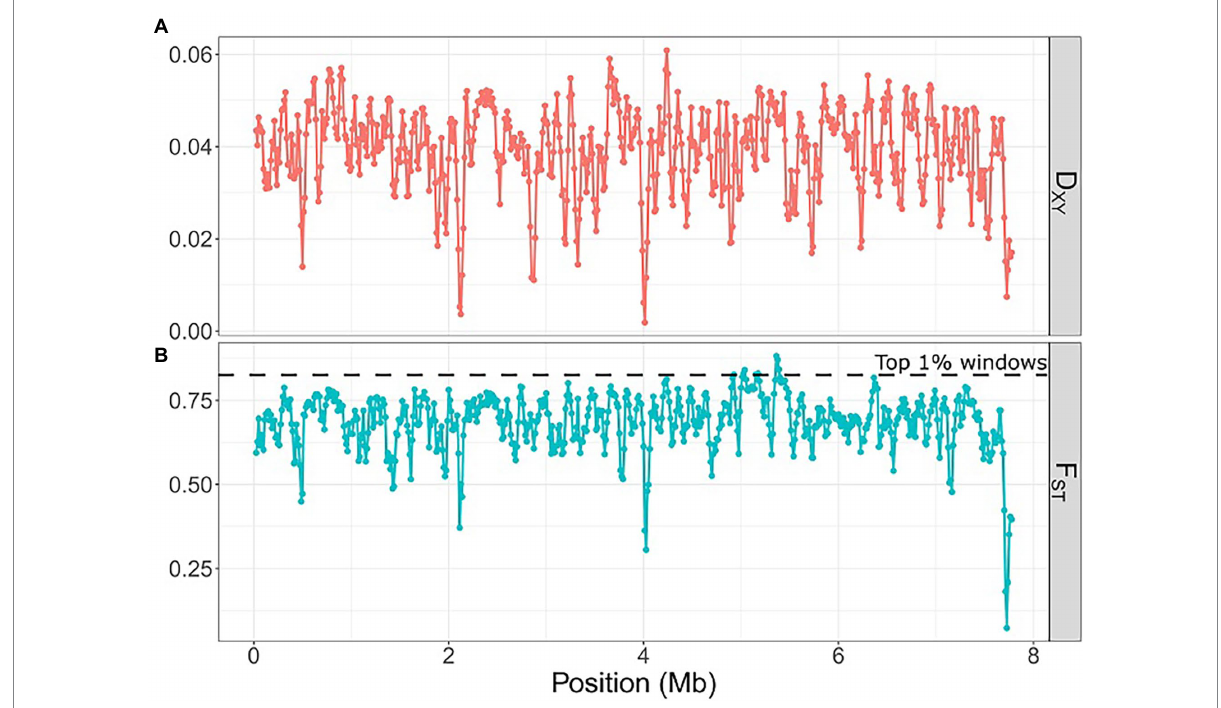
FIGURE 4 Scatter plot of absolute divergence (D XY ) and fixation index (F ST ) between the D2 and D3 Laspinema populations using 50 kb windows with 12.5 kb step along the Laspinema genome. The horizontal dashed line indicates loci within the 0.99 percentile of F ST. Scatter plots were created using the ‘ggplot2’ (Wickham, 2016) package in R. (A) D XY , (B) F ST .